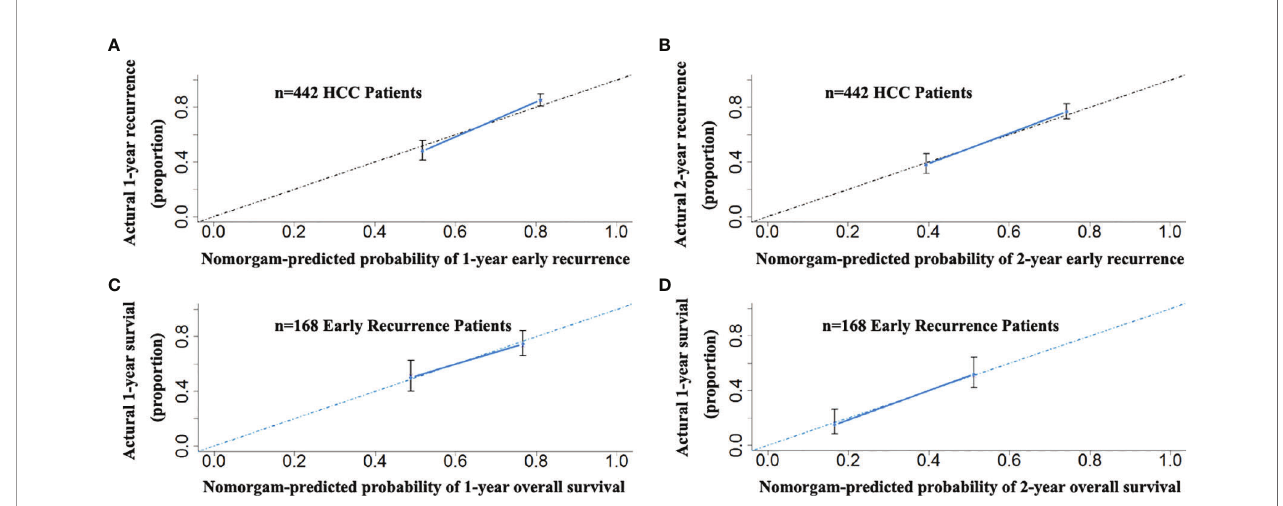
FIGURE 8 | The calibration curves for the probability of 1- and 2-year RFS nomogram showed good agreement between prediction and observation in the probability of early recurrence in the total of 442 patients with HCC (A, B) . The calibration curves for the probability of 1- and 2-year OS nomogram showed good agreement between prediction and observation in the probability of overall survival in 168 early recurrence patients with HCC (C, D)